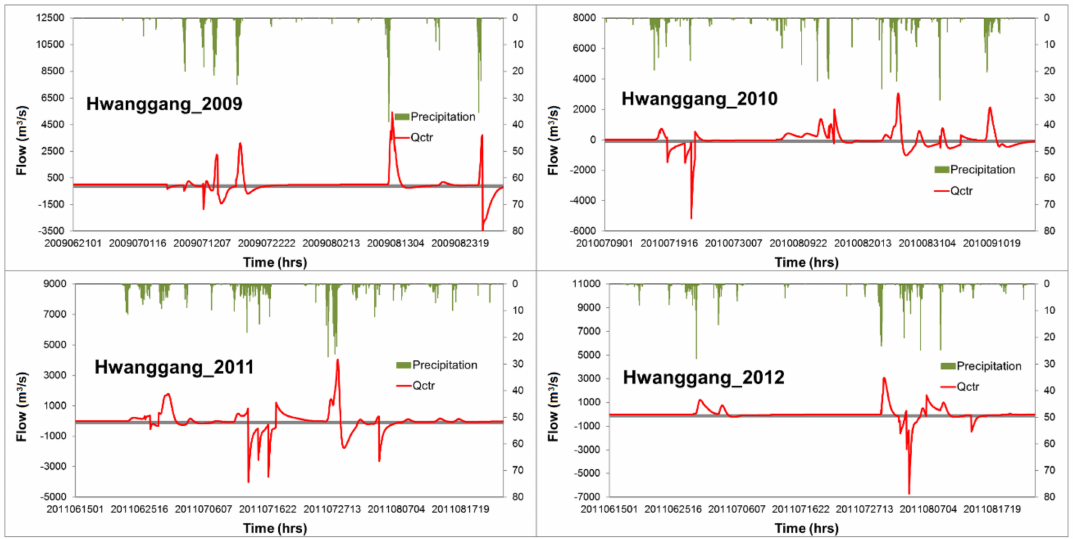
Figure 4. The simulated and observed discharges at Gunnam station in 4 flood events (2009, 2010, 2011, and 2012) after considering dam